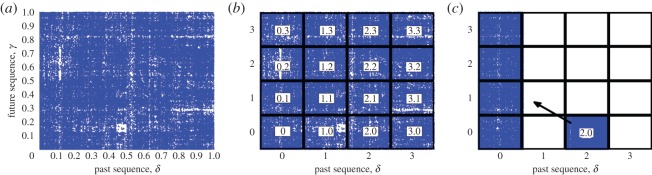
Symbolic space of the DNA of E. coli with horizontal axes representing the encoding of past sequences δ and vertical axes representing the encoding of future sequences γ. The grid lines represent a partition with N=4. (a) Symbolic space of the DNA of E. coli where existing words are represented by blue points and white space represents the presence of forbidden words. (b) Symbolic space with a grid partition where the boxes define regions of points that encode similar words forming a group. (c) Symbolic space representing how points from a box move to four other boxes.